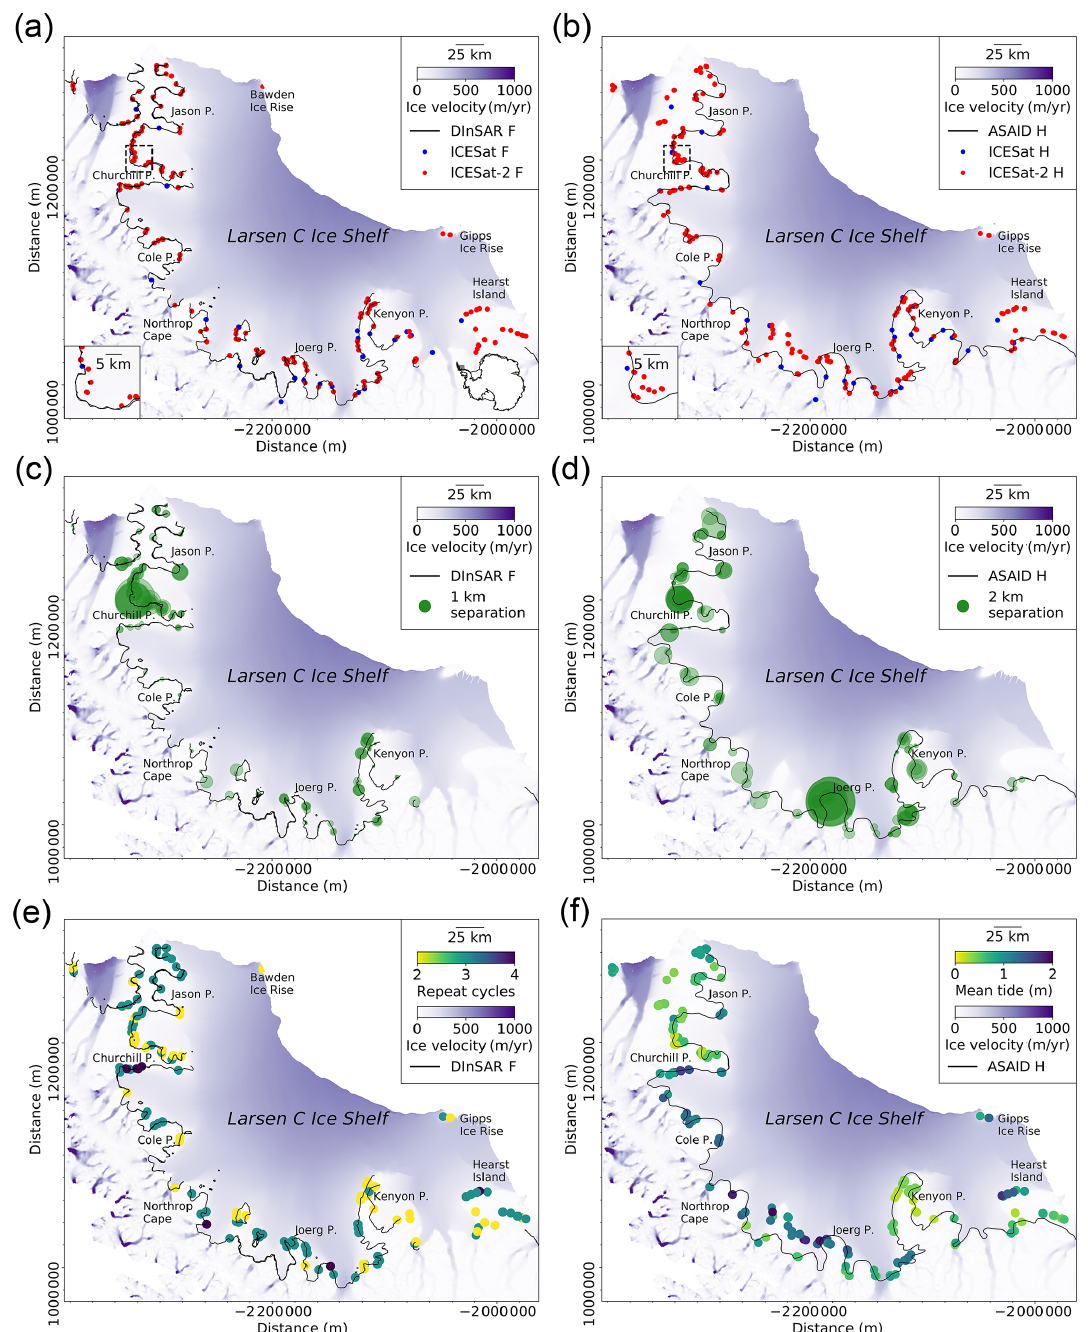
Figure 7. Spatial distributions of ICESat-2-derived GZ features. (a) ICESat-2-derived inland limits of tidal flexure (Point F; red dots). For comparison, ICESat-derived Point F (Brunt et al., 2010a) locations are also shown (blue dots); ESA CCI DInSAR-derived Point F is shown as the black line (ESA, 2017). (b) Same as (a) , but showing the ICESat-2-derived inland limit of hydrostatic equilibrium (Point H; red dots) and ICESat-derived Point H (Brunt et al., 2010a) (blue dots); Point H from the ASAID grounding line project is shown as the black line (Bindschadler et al., 2011). (c) Absolute separations between ICESat-2-derived Point F and ESA CCI DInSAR-derived Point F. (d) Absolute separations between ICESat-2-derived Point H and ASAID Point H. (e) Number of repeat cycles used to calculate the grounding zone (GZ) features. (f) Distribution of mean ocean tide range at Point H. In all subplots, data are superimposed over recent ice surface velocity magnitudes (Rignot et al., 2017) in Antarctic polar stereographic (epsg:3031)